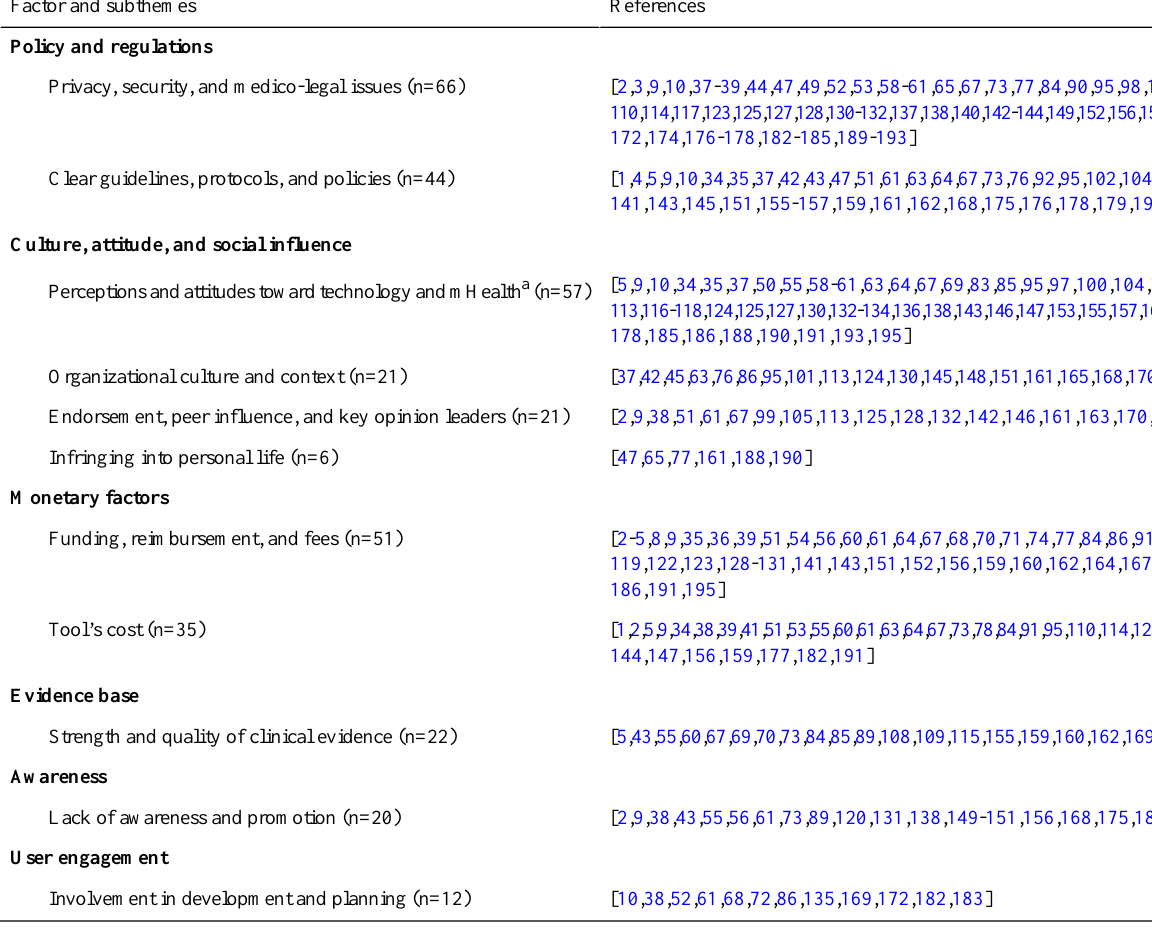
Table 5. Other social and organizational factors and their occurrence, with